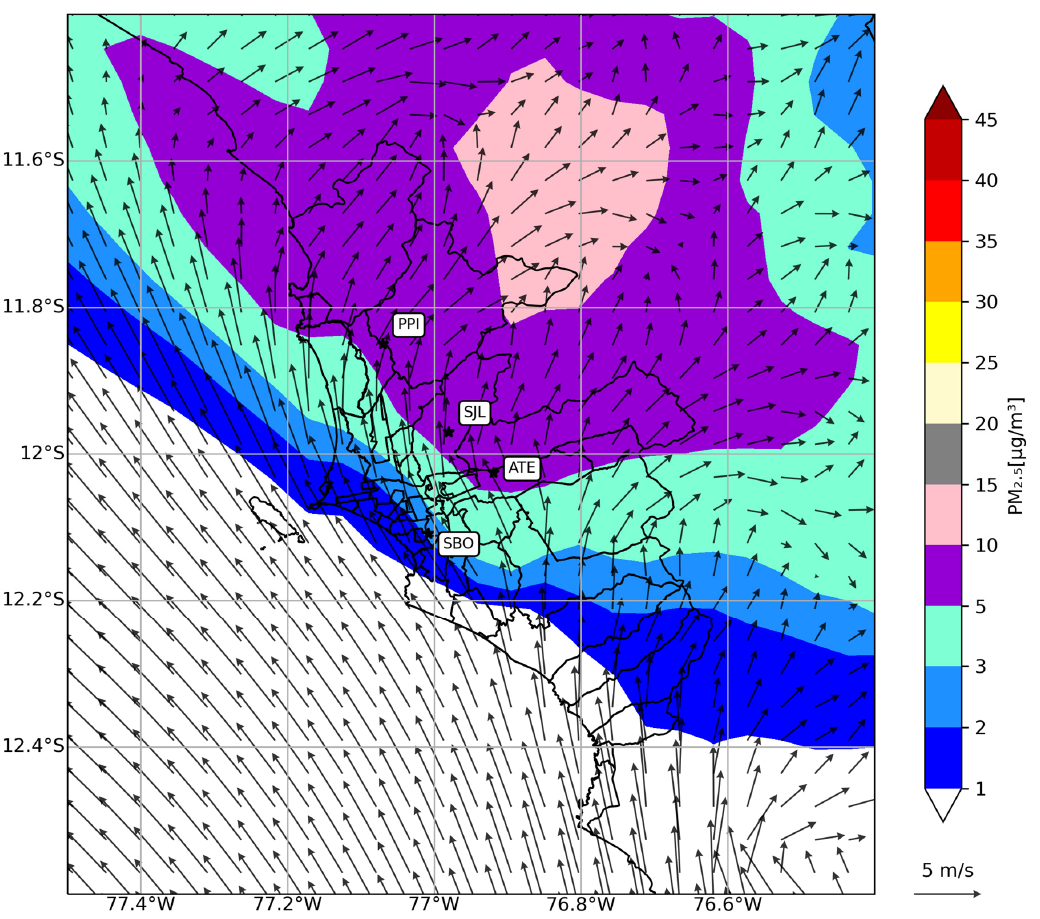
Figure 9. WithoutAerosol (vehicular emission of gasses + without vehicular emission of aerosols): simulation of the mean PM 2.5 concentration (µg/m 3 ), considering the vehicle gas emissions and without vehicles aerosol emission (sensitivity simulation) for the entire study period. Namely, ATE, SBO, SJL and PPI illustrate the locations of the stations: ATE is Ate, SBO is San Borja, SJL is San Juan de Lurigancho (SJL), and PPI is Puente Piedra. A colorful vertical legend indicates the different PM 2.5 values.